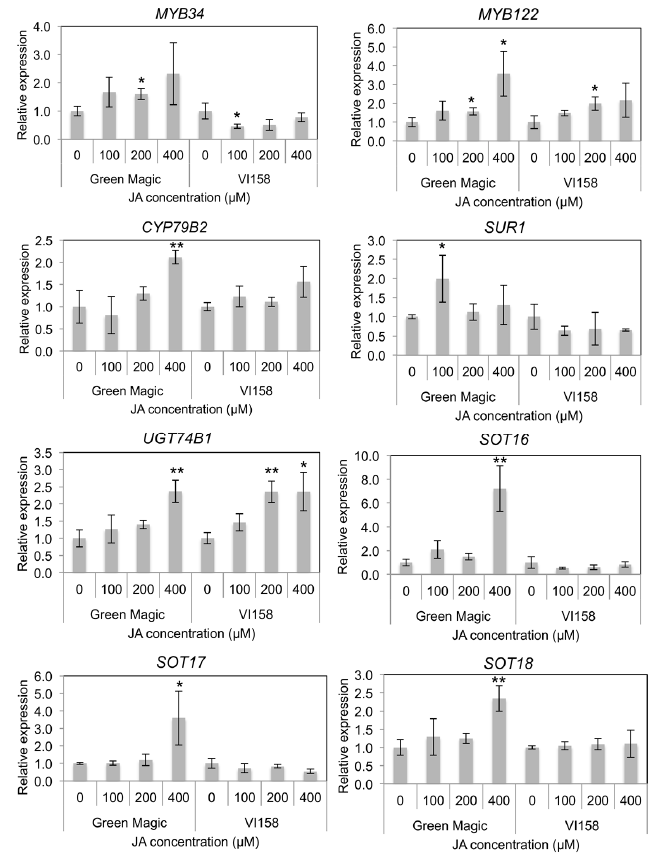
Figure 3. Histograms representing changes in relative transcript abundance of transcription factors and glucosinolate core structure synthesis genes for different cultivar/treatment combinations. Asterisks indicate significant differences from the control within the same cultivar determined by Student’s t -test at p = 0.05 (*) and p = 0.01 (**), respectively.